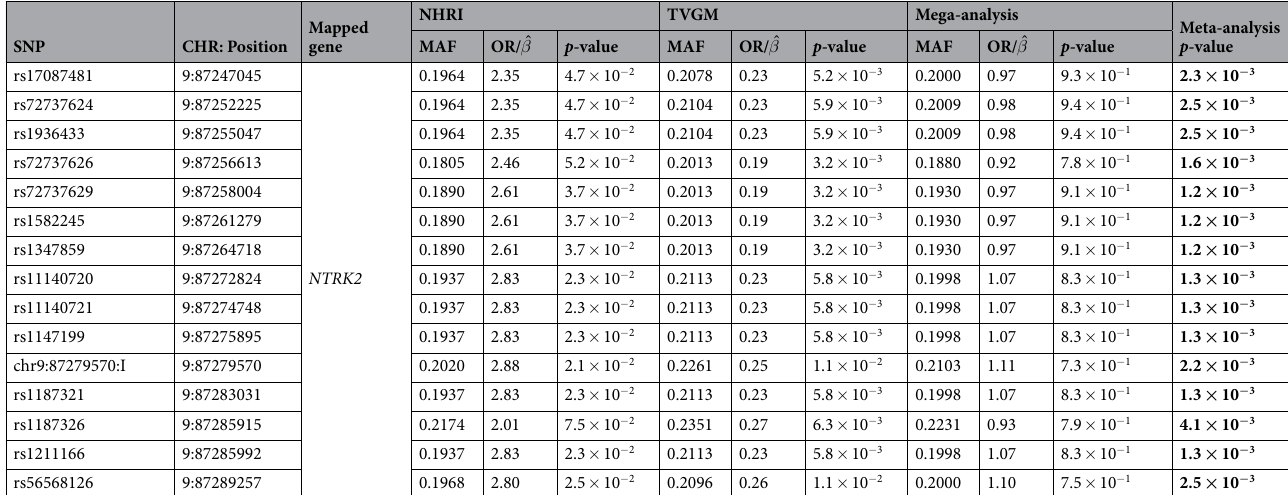
Table 3. BDNF -related susceptibility loci for major depressive disorder that related to response to antidepressant drug treatment in Han Chinese. Abbreviation: SNP, single nucleotide polymorphism; CHR, chromosome; MAF, minor allele frequency; OR, odds ratio. a Association analyses were based on 421 MDD subjects, using linear (or logistic) regression with an additive model (1-degree of freedom) after adjusting for gender and age. b Meta-analysis p -value was calculated using the Fisher exact method. c Only SNPs that reached p -value at the level of 5.0 × 10 − 4 (or 5.0 × 10 − 3 ) either in mega-analysis or in meta-analysis were reported as significant (or suggestive) markers. d SNPs highlighted in bold are chip